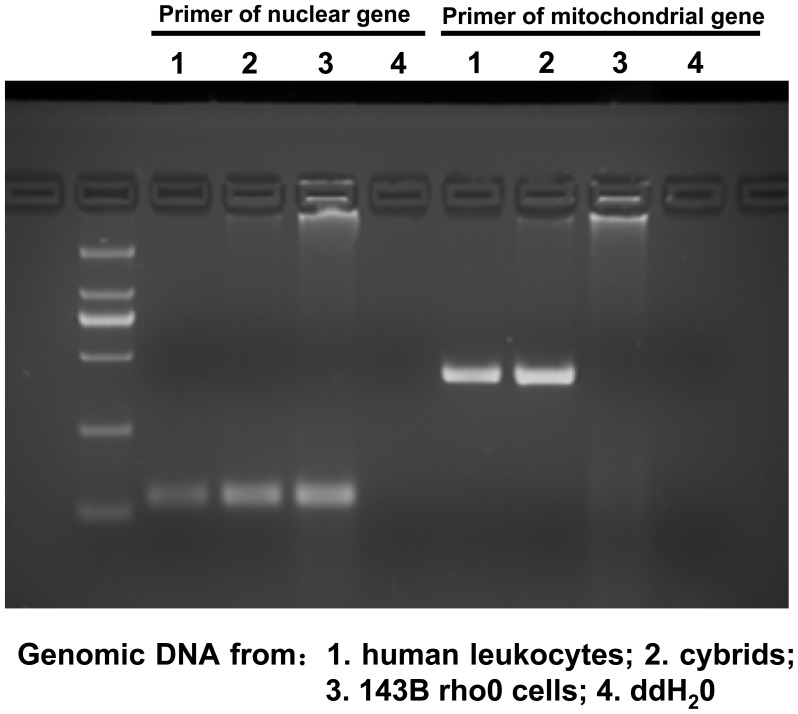
Identification of the transmitochondrial cybrids by PCR.